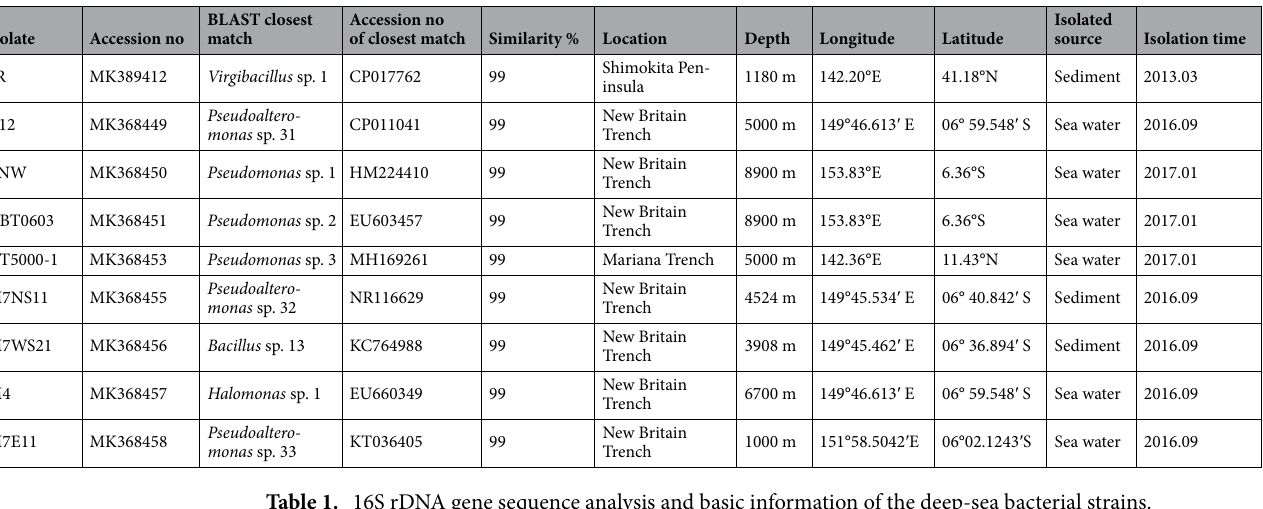
Table 1. 16S rDNA gene sequence analysis and basic information of the deep-sea bacterial